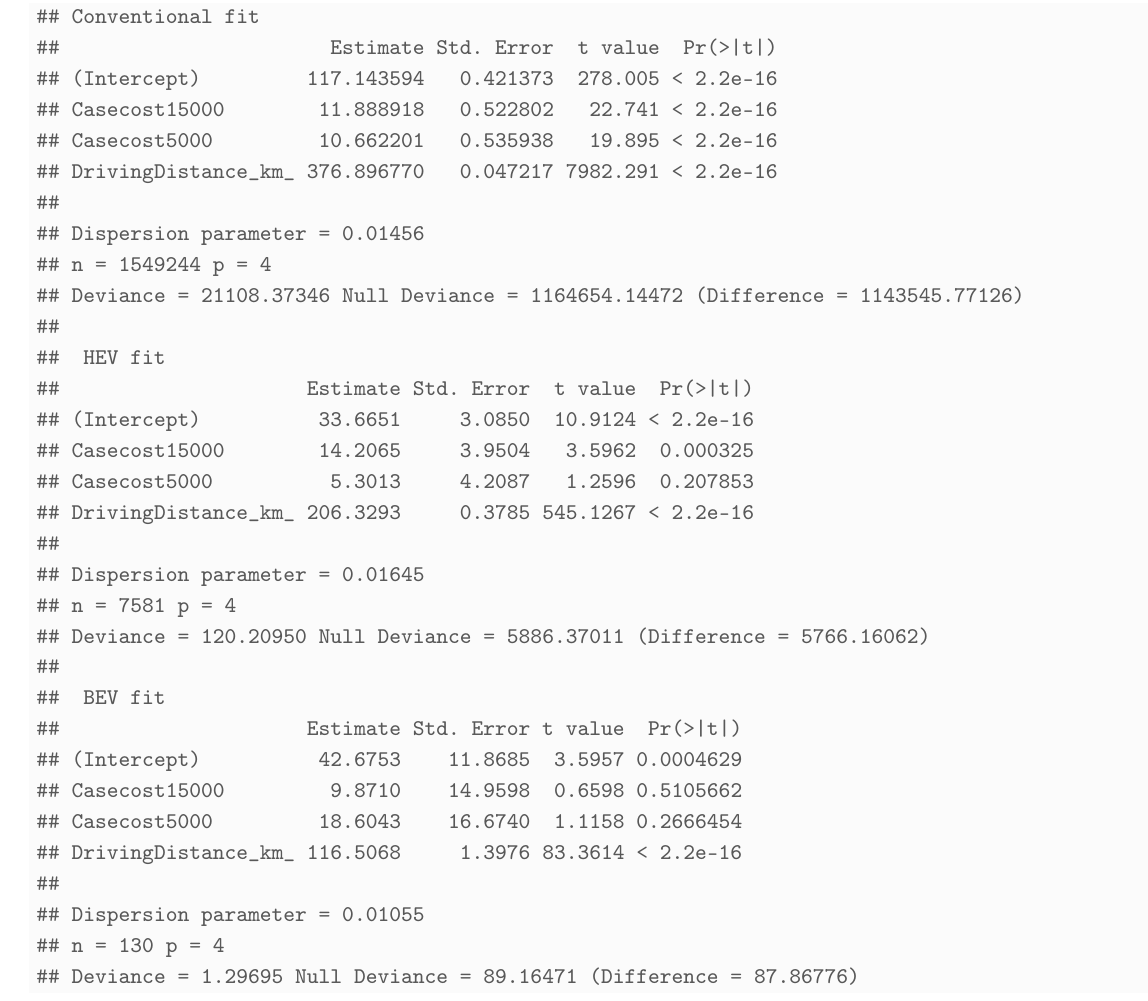
Figure 11. Resulting fit for different powertrains with respect to different penetration level estimates.